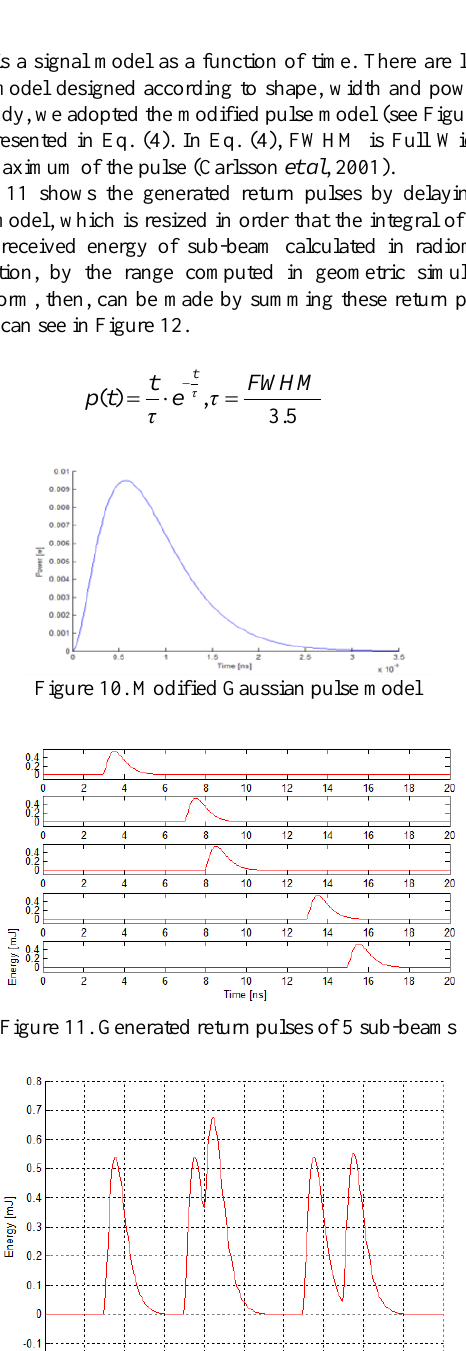
Figure 15. S-shaped profile by CFD